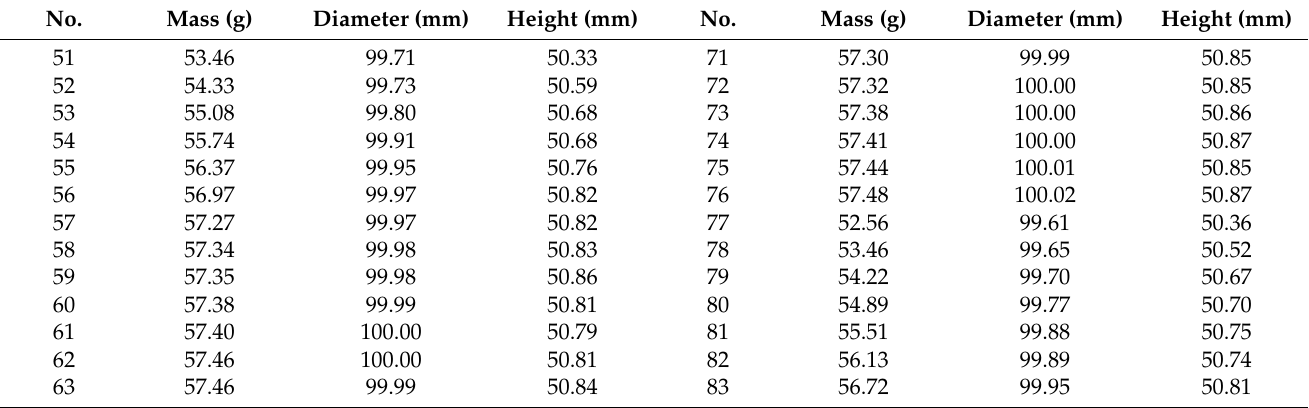
Table A2. Product qualities for injection molding conditions with nonlinearity according to packing